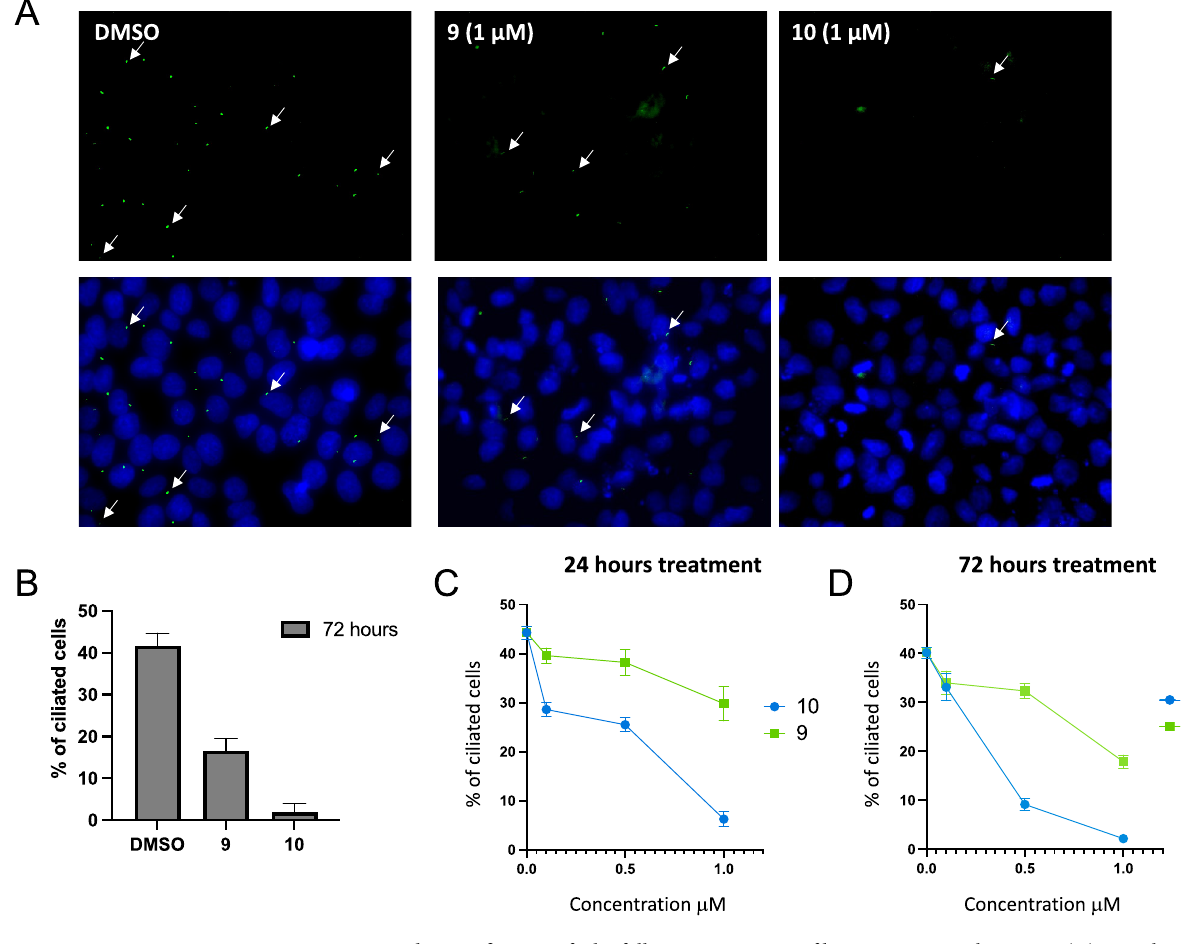
Figure 5. Images and quantification of cilia following treatment of human iPSCs with 9 or 10 . ( A ) Visualization of cilia on human iPSCs following 72 h continuous starvation and treatment with DMSO or 1 μM of either 9 or 10 at 40 × magnification. Arrows are used to highlight the location of some cilia in each panel and a legend of the stains used to visualize cilia and nuclei is placed above the panels. Primary cilia are labeled with the Arl13b antibody (green) and the nuclei with DAPI (blue). ( B ) Quantification of the percentage of ciliated cells per single field in ( A ). Error bars represent the SEM. ( C , D ) Quantification of the percentage of ciliated cells averaged from six random visual fields following 24 h ( C ) or 72 h ( D ) of continuous treatment plus starvation and in the presence of different concentrations of 9 or 10 . Error bars represent